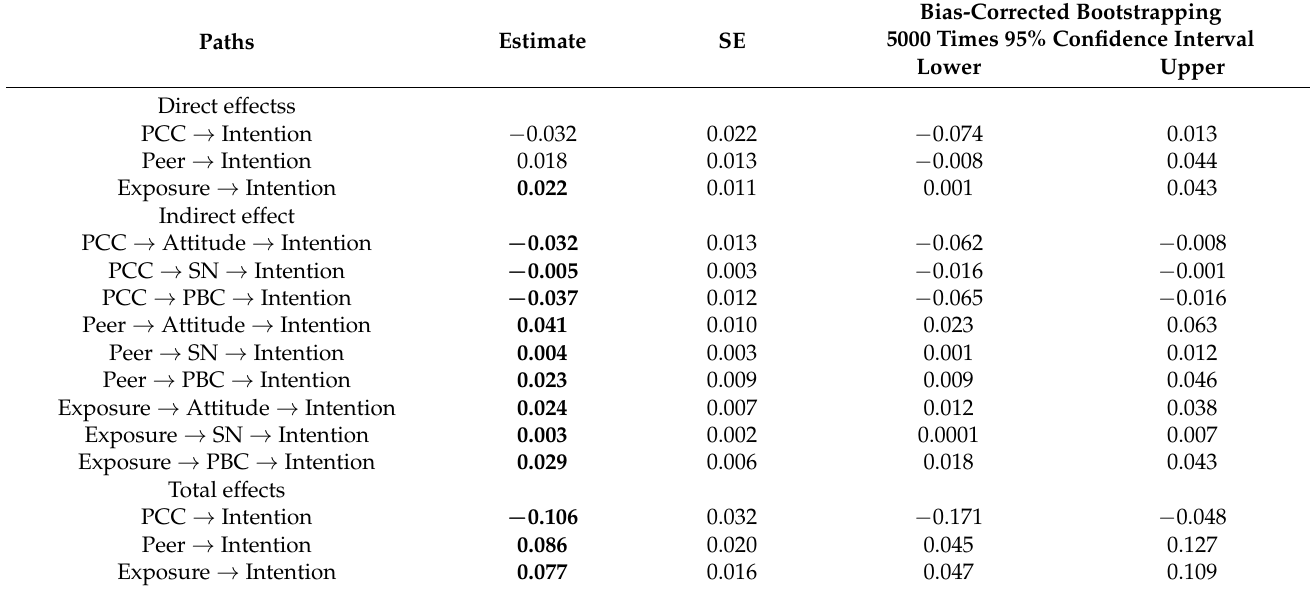
Table 4. Direct, indirect, and total effects of the hypothesized model ( n =